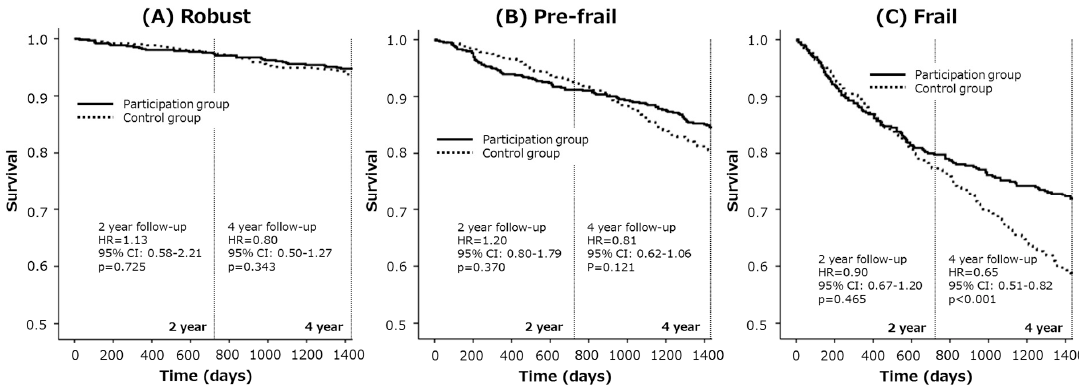
Figure 2. Kaplan-Meier survival curves for new LTCI service requirements are presented to compare the disability incidence in robust ( A ), pre-frail ( B ), and frail older adults ( C ). In the frail older adults but not in the robust or pre-frail older adults, the participation group had a significantly lower risk of needing LTCI services than the control group. In the frail older adults, the hazard ratios for new LTCI service requirements in the participation group compared with the control group in two- and four-year follow-up periods were 0.90 (95% CI = 0.67–1.20) and 0.65 (95% CI = 0.51–0.82), respectively.